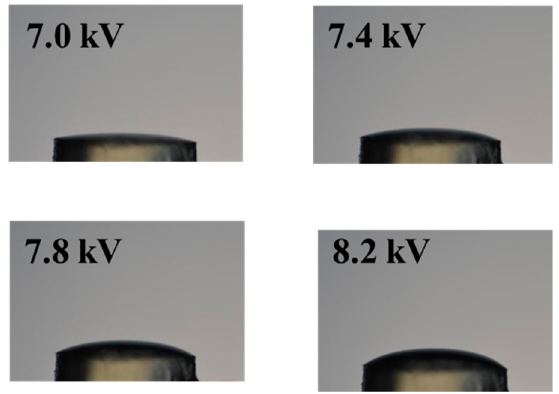
Figure 5. Surface evolution of the liquid lens with an increasing voltage, which shows the liquid silicone bulging outside of the tube.